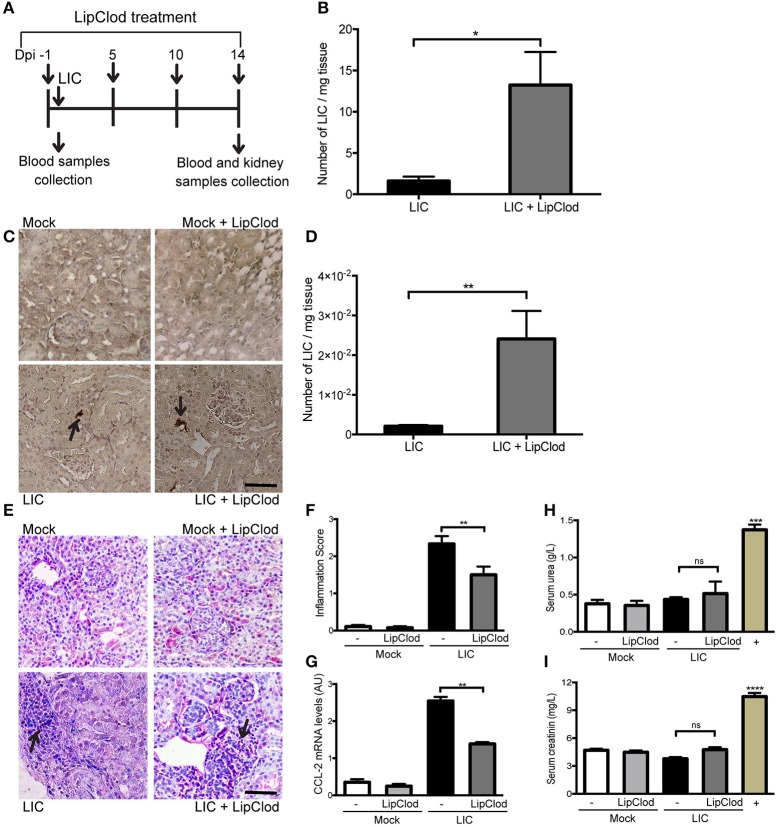
Depletion of macrophages resulted in a higher bacterial burden, reduced subacute nephritis, and unaltered renal function. (A) Treatment scheme for intraperitoneal depletion and infection in Mock, Mock + LipClod, LIC and LIC + LipClod groups of C57BL/6J mice. (B) Bacteremia levels at 1 day post-infection (dpi) were significantly increased in LIC-infected mice depleted of macrophages. (C,D) At 14 dpi, kidneys sections of all groups of mice were immunostained for LipL32 (the major Leptospira interrogans antigen) and also bacterial load in LIC + LipClod group resulted in higher levels compared to undepleted but LIC-infected mice. (E–G) Representative haematoxylin-eosin staining of kidney sections. An inflammation score was established by a pathologist and CCL-2 mRNA was quantified by qRT-PCR as a molecular marker of inflammation; β-actin was used as a housekeeping control. Significantly diminished levels of inflammation were detected in LIC + LipClod group. (H,I) Normal urea and creatinine levels in serum samples from all experimental groups were detected and assayed as a measure of renal functions at 14 dpi. Serum samples from LIC-infected gerbils were used as a positive control (+). In all cases, data represent assays of two independent experiments of groups of 6 animals, each. Bars indicate 50 microns; AU, arbitrary units; nsP > 0.05; *P < 0.05; **P < 0.01; ***P < 0.001; ****P < 0.0001.